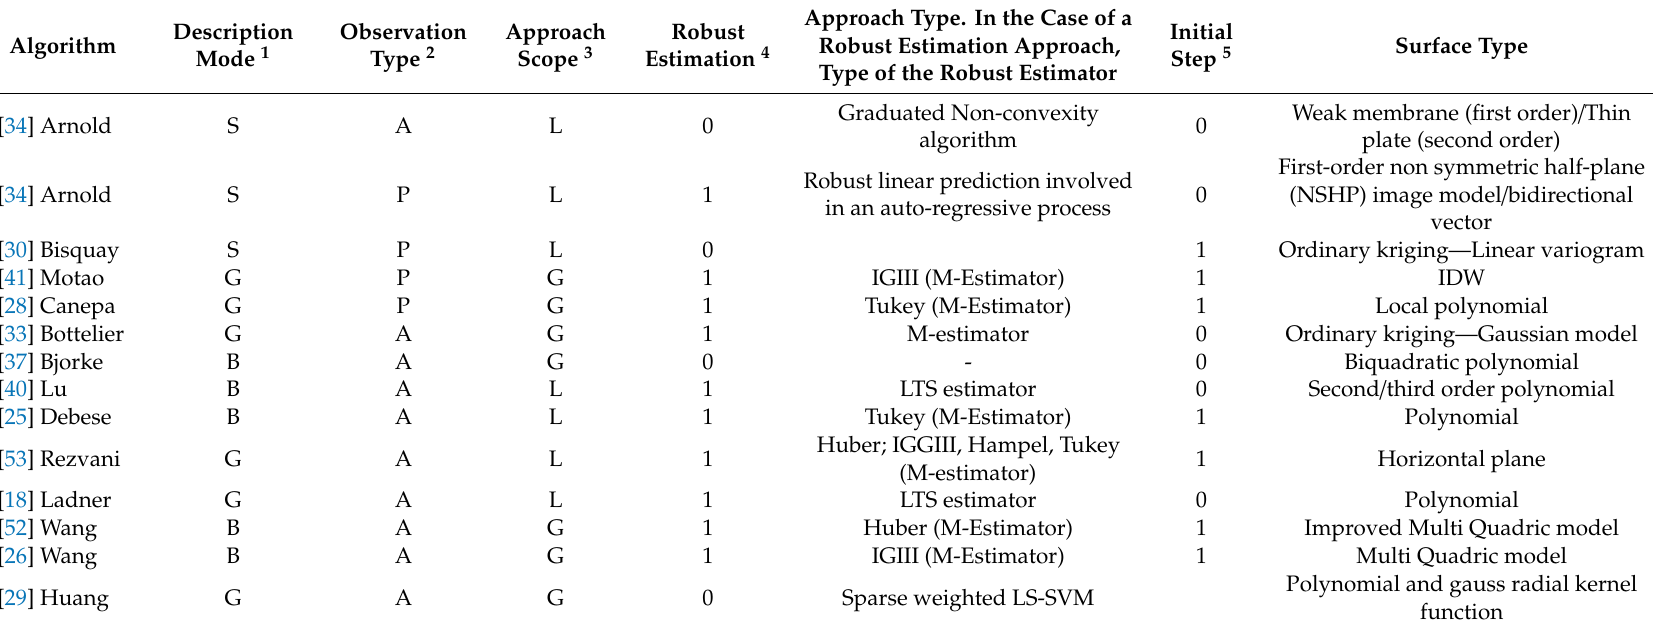
Table 3. Characteristics of surface-oriented